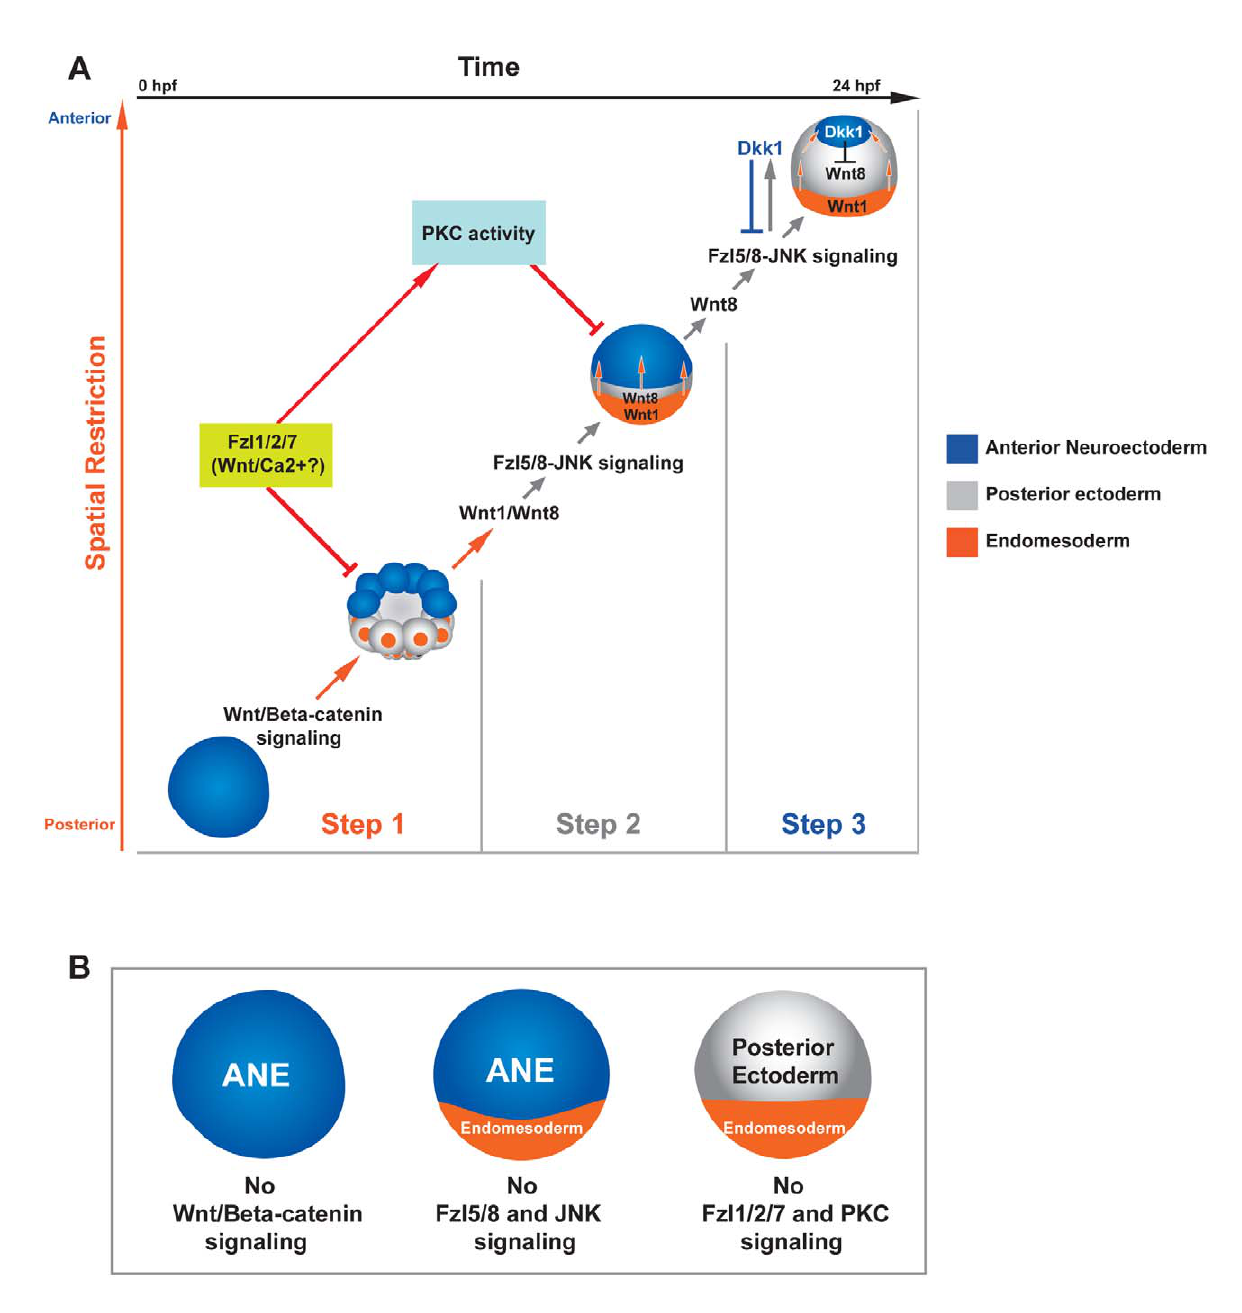
Figure 7. Three-step model for the balance of Wnt signaling interactions during ANE restriction. (A) The y -axis monitors the progress of spatial restriction of the ANE (blue), and the x -axis indicates the developmental timing of ANE restriction. Each image represents the position of the ANE in time and space. (Step 1) Initially, the maternal regulatory state in the absence of Wnt signaling supports ANE specification throughout the embryo. Then, n b -catenin signaling in the posterior half of the embryo activates an unknown negative regulatory activity that blocks the accumulation of ANE factors, either by blocking their transcription directly or the activity of their ubiquitously expressed maternal activators. (Step 2) As development progresses, posterior n b -catenin activates production of at least two Wnt ligands, Wnt1 and Wnt8, that are necessary to initiate the ANE restriction mechanism in posterior ectoderm beginning at the 60-cell stage. These secreted ligands signal through the Wnt receptor, Fzl5/8, activating the JNK pathway. The Wnt/JNK pathway progressively down-regulates expression of ANE factors during early blastula stages in all but the most anterior ectoderm. During Step 1 and possibly Step 2, Fzl1/2/7 signaling attenuates the n b -catenin- and Fzl5/8-JNK-mediated down-regulation of ANE factors, preventing complete shutdown of ANE specification. PKC activity also antagonizes Fzl5/8-JNK-mediated ANE restriction, downstream of Fzl1/2/7 signaling. (Step 3) Expression of Wnt8, Wnt1, and/or another ligand X is activated in more anterior blastomeres. These ligands continue Fzl5/8-mediated ANE restriction until the late blastula-stage embryo activates production of the secreted Wnt antagonist, Dkk1, via Fzl5/8. Through negative feedback, Dkk1 limits Fzl5/8 activity, thereby defining the borders of the ANE. Orange arrows indicate the Wnt/ b -catenin-mediated mechanism, gray arrows indicate the Wnt/JNK mediated mechanism, and red indicates Fzl1/2/7 and PKC interactions. (B) Diagram showing the state of the ANE in embryos lacking either Wnt/ b -catenin, Fzl5/8 and pJNK, or Fzl1/2/7 and pPKC signaling. doi:10.1371/journal.pbio.1001467.g007 PLOS Biology |